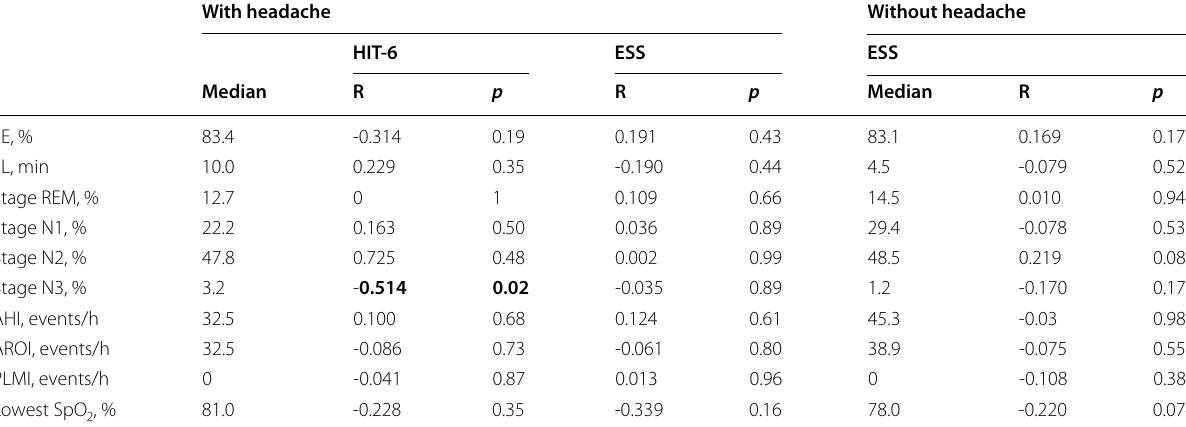
Table 3 Relationship between polysomnography parameters and questionnaire scores